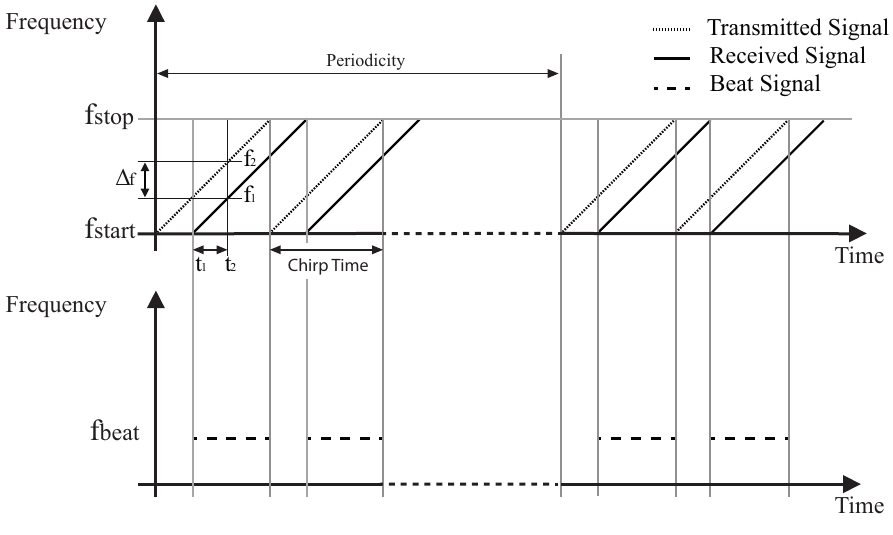
Figure 1. RADAR frame